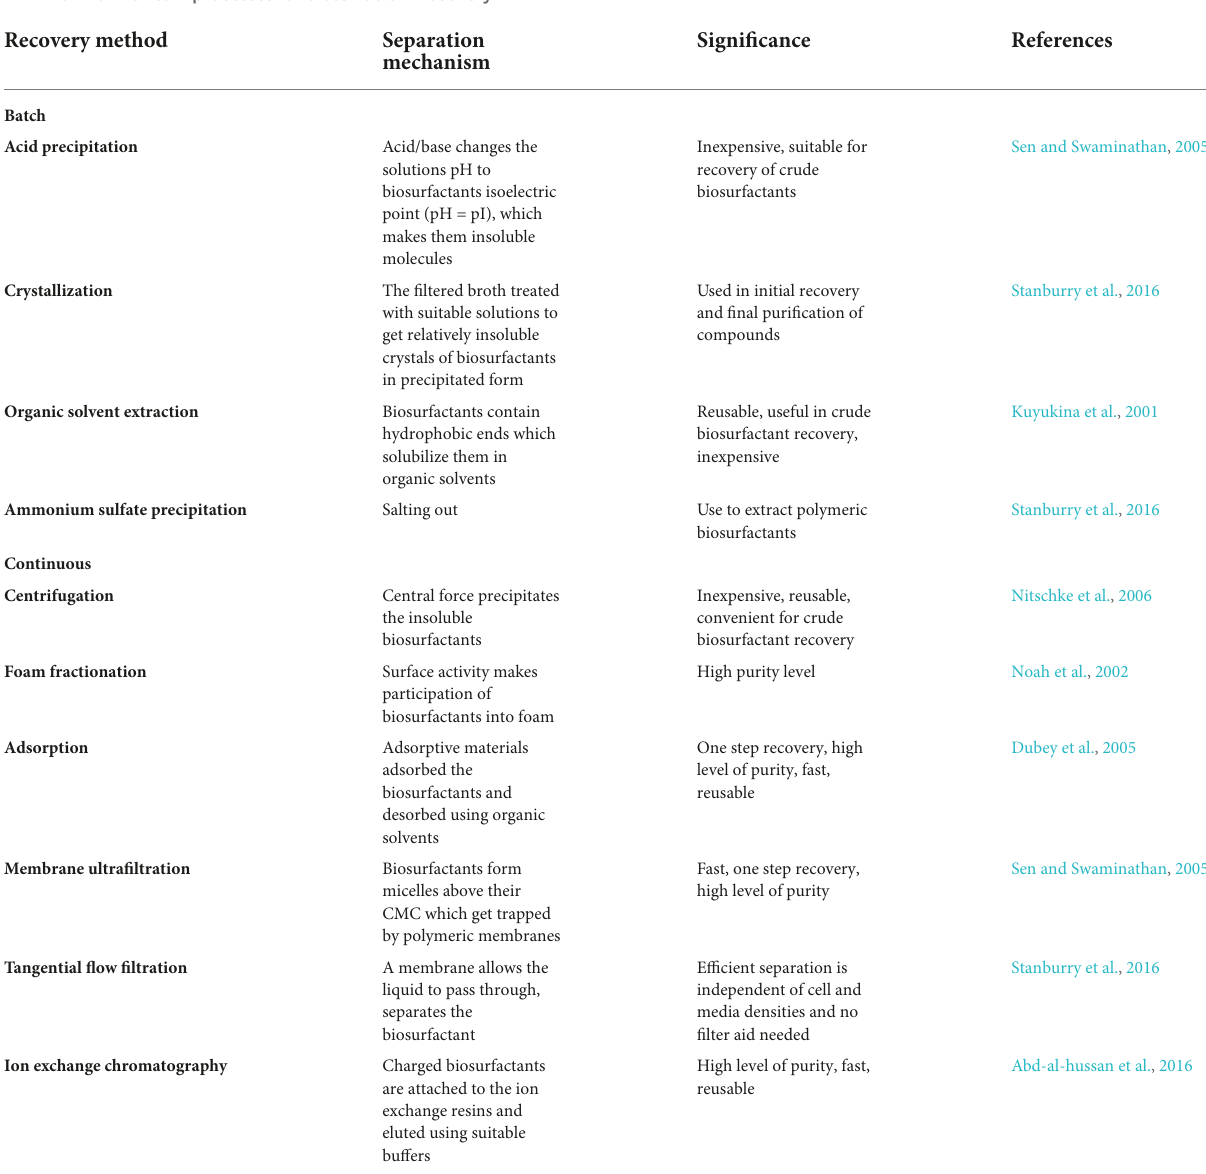
TABLE 3 Downstream processes for biosurfactant